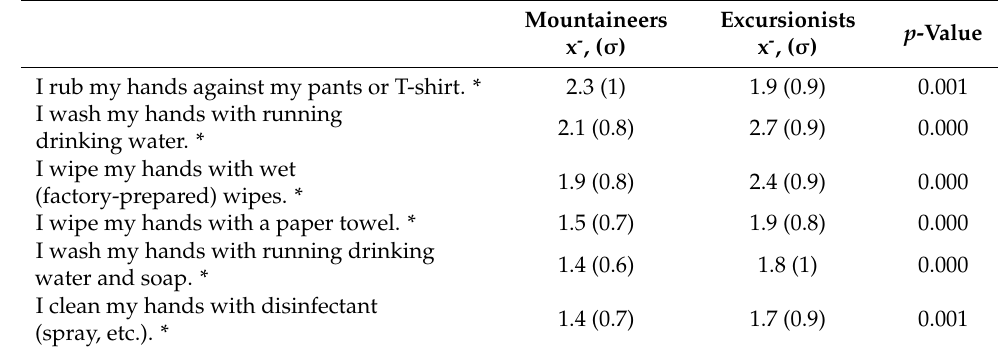
Table 5. Measures regarding hand hygiene in